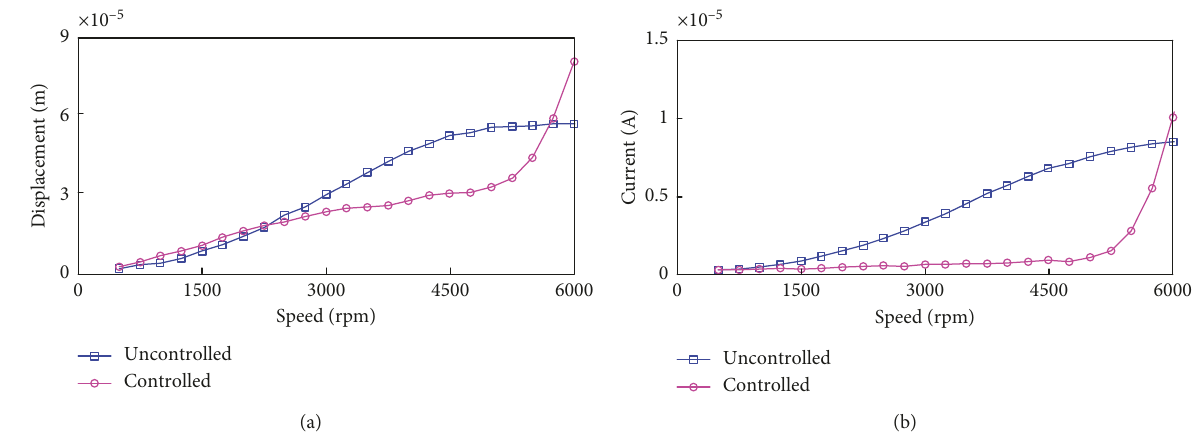
Figure 11: Comparison of vibration response at different speeds: (a) vibration displacement and (b) control current.